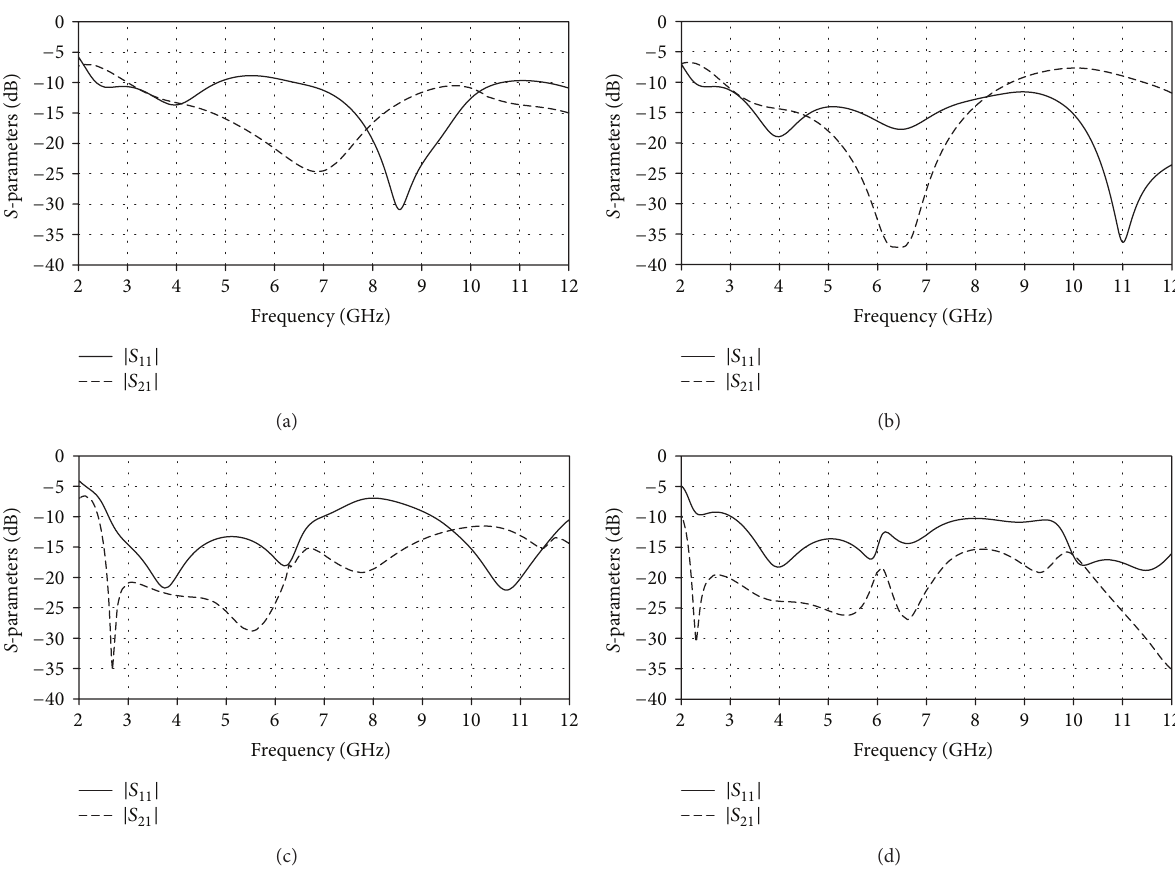
Figure 2: Simulated reflection coefficient |𝑆 11 | and isolation |𝑆 21 | against frequency of the proposed antenna: (a) without all of the slots and the stub in the ground plane, (b) without two rectangular slots and the stub in the ground plane, (c) without the stub in the ground plane, and (d) with all of the slots and the stub in the ground plane, that is, the proposed